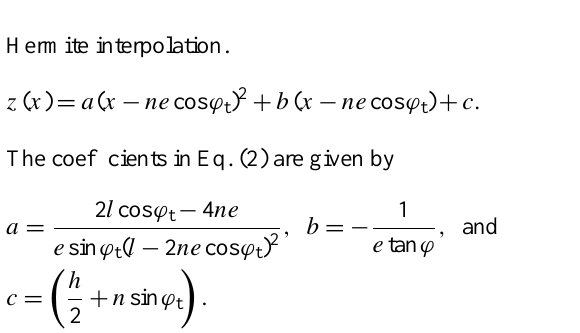
Figure 3. Notch shapes with different ϕ t ( e = 2 and ϕ t ranges from − 7 π to − 3 π ). 16 16